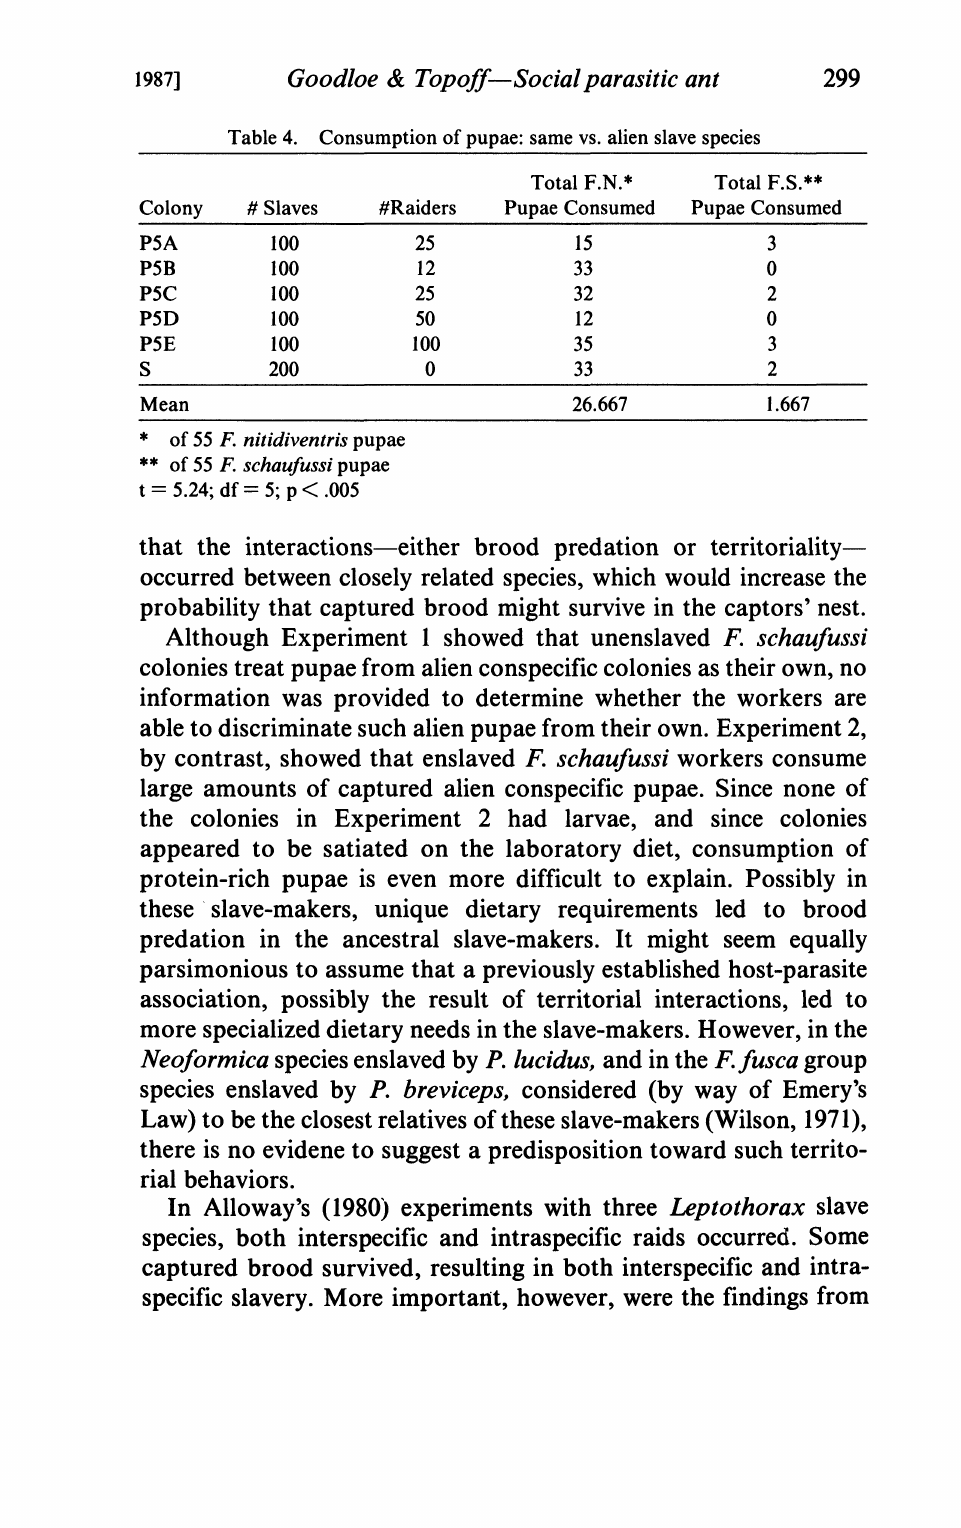
Total F.N.* Total